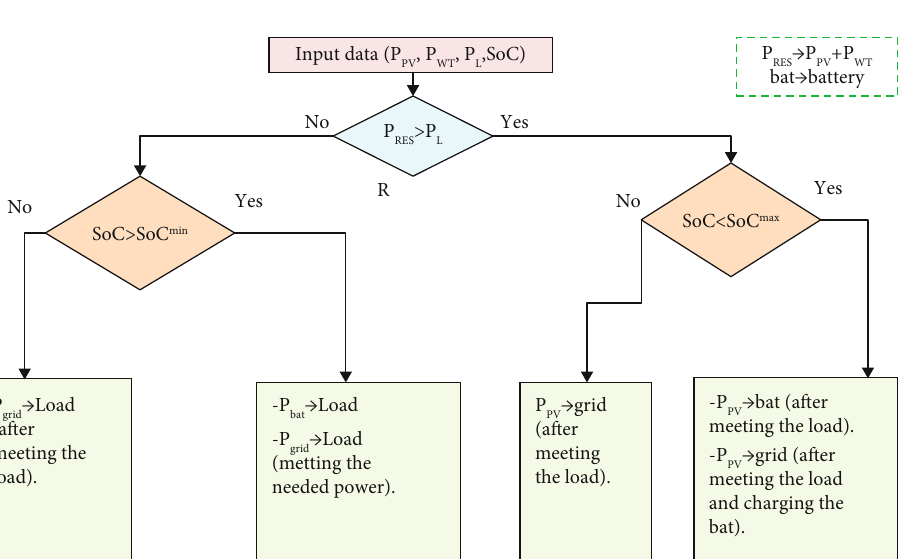
Figure 2: Time-of-use tari ff [27].